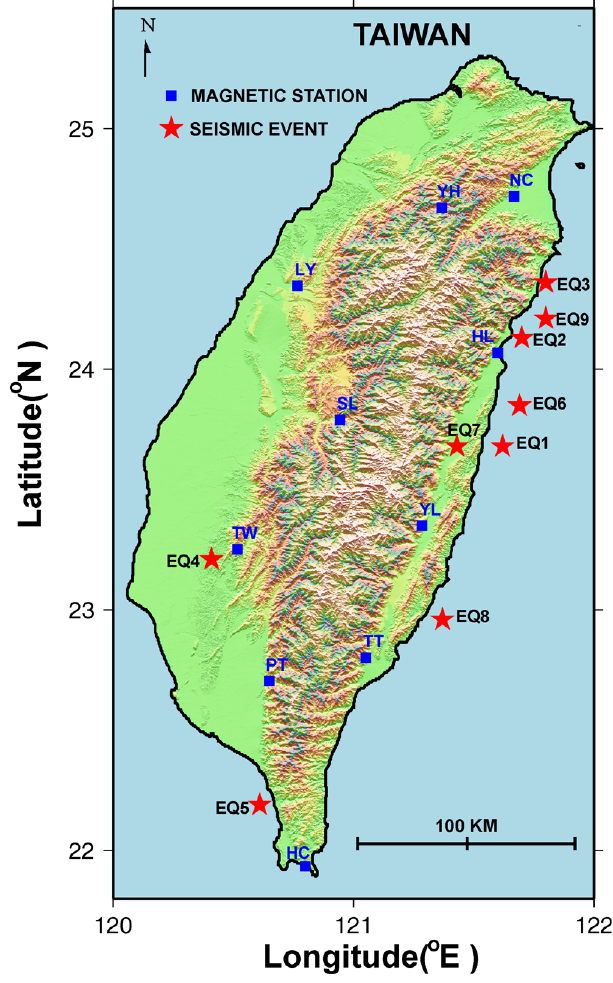
Fig. 1. The topographic map of Taiwan. The red stars denote the epicenters of 9 studied earthquakes. Blue squares show locations of the geomagnetic stations in